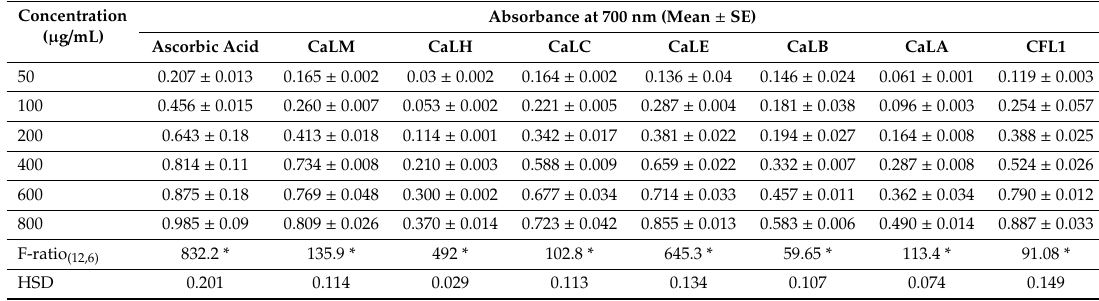
*indicates the significant difference at p ≤ 0.05; SE = Standard error.